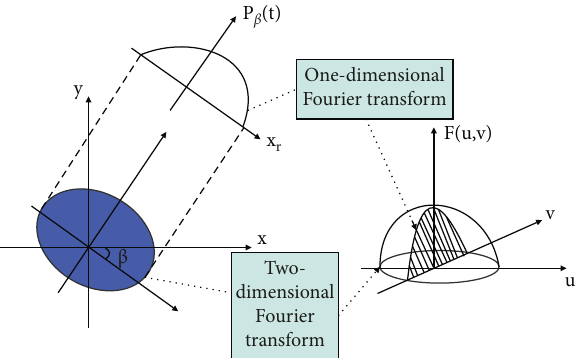
Figure 3: Schematic diagram of the central slice theorem.